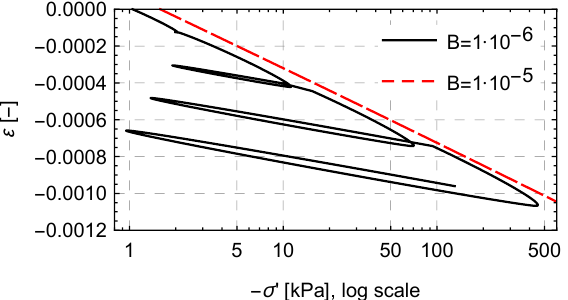
Figure 10. Relationship between log σ (cid:48) and strain produced by the model for η = 20 MPa · min for two different strain rates.